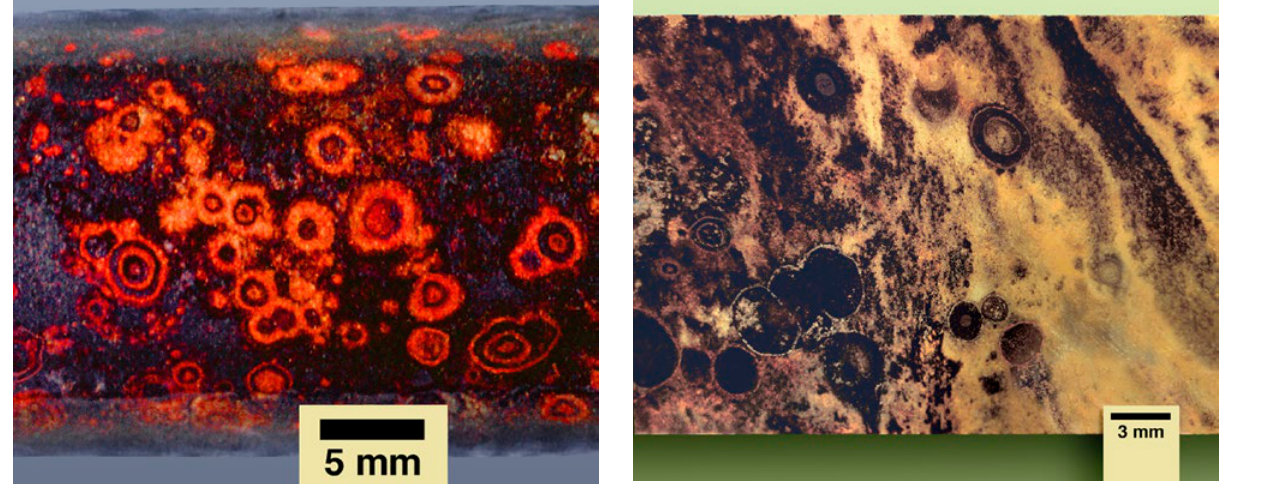
Figure 65. Red jasper-magnetite oolites are found in the lower parts of the Peko diapiric quartz-magnetite ore breccia pipe at Tennant Creek, N.T. Composite ooolites and some disruption of the rims reflect the soft nature of the precursor magnetite (lepidocrocite) and particulate colloidal silica. The texture and the metacolloidal jasper leave no doubt that this lode was emplaced as a precursor colloidal mass.